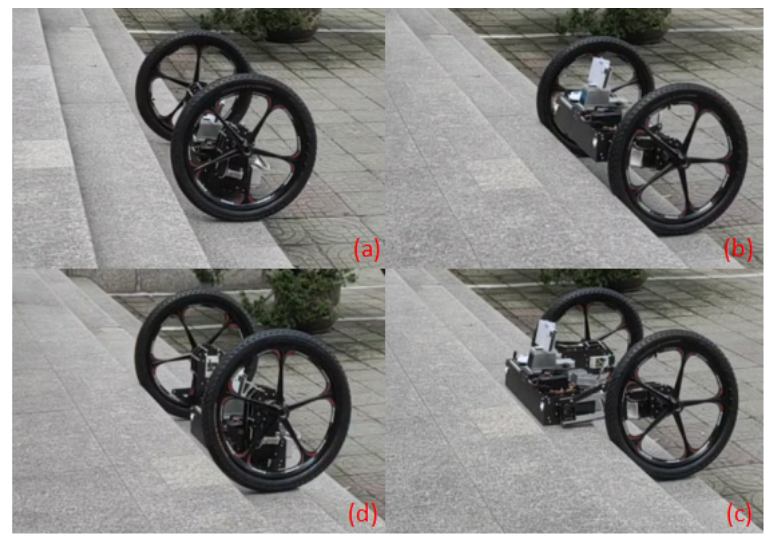
Figure 16. Robot climbing test process: ( a ) the robot approaches stairs; ( b ) the robot’s cantilevers lifts the frame; ( c ) the robot extends its cantilevers and puts its frame on the stairs; ( d ) the robot’s wheels are lifted onto the steps of the frame and the robot enters an “approaching” gait again. In the prototype climbing experiment, we measured the experimental data of the vertical inclination angle of the left and right cantilevers and the current of the left and right main driving motors in the climbing process of the robot under the condition of two rounds of blocked rotation. The left main driving motor was motor 1, and the right main driving motor was motor 2. The measurement results of each data are shown in Figures 17 and 18. Among them, “a, b, c, and d” were separated by black solid lines, representing the four stages of the robot climbing gait “lifting, putting retraction and approaching”, respectively. The interval b1 and b2 are two subintervals separated by the blue line of the interval b, and b1 denotes the process of cantilever stretching to the longest in the gait released by the robot. b2 Represents the process in which the frame is lowered at the longest cantilever in the gait of the robot.